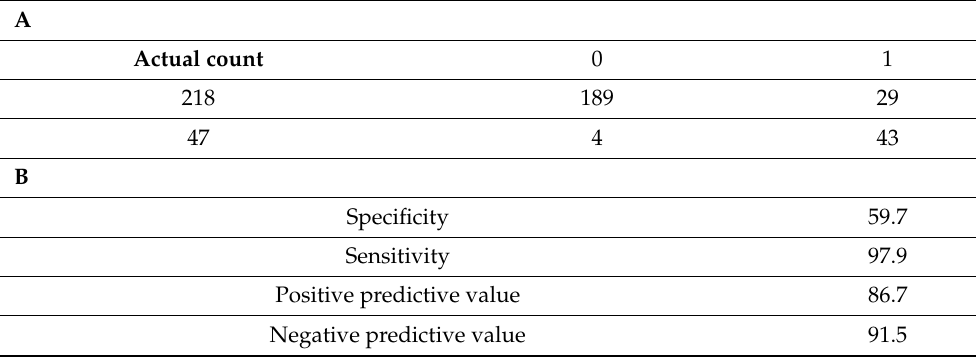
Table 4. The validity (predictive power) of age, NLR, BUN, and use of HFNC, and mortality in COVID-19 patients. The accuracy of the calculations is 87%. ( A ): The number of samples: Predicted condition—218, survival; 47, death; and true condition, 0 for disease and 1 for no disease. ( B ): the sensitivity, specificity, positive predictive value and negative predictive value.